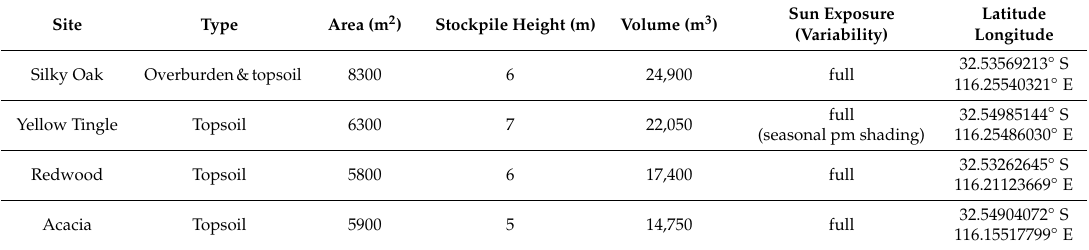
Table 3. Description of stockpile sites used to test survival of Phytophthora cinnamomi in woody inoculum plugs at 10 and 50 cm. Sun exposure: seasonal shading = site shaded by adjacent vegetation each afternoon,